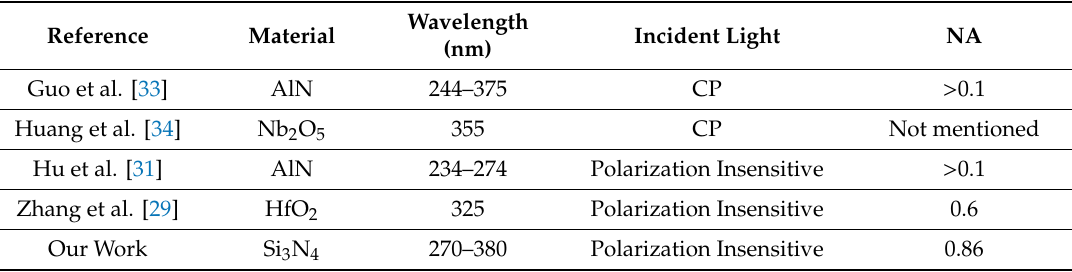
Table 1. Summary of our results and other references.